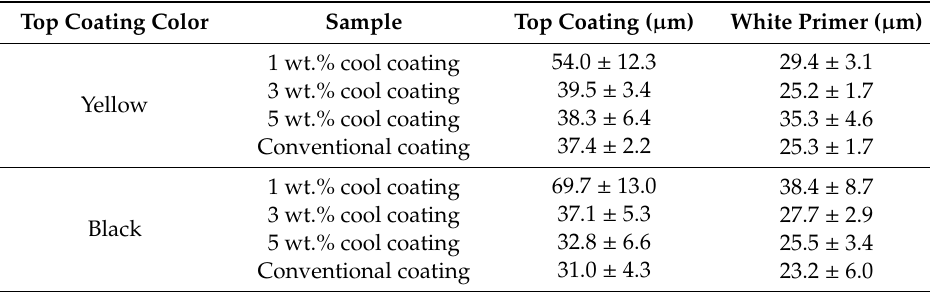
Table 1. Dry film thickness of each coating.